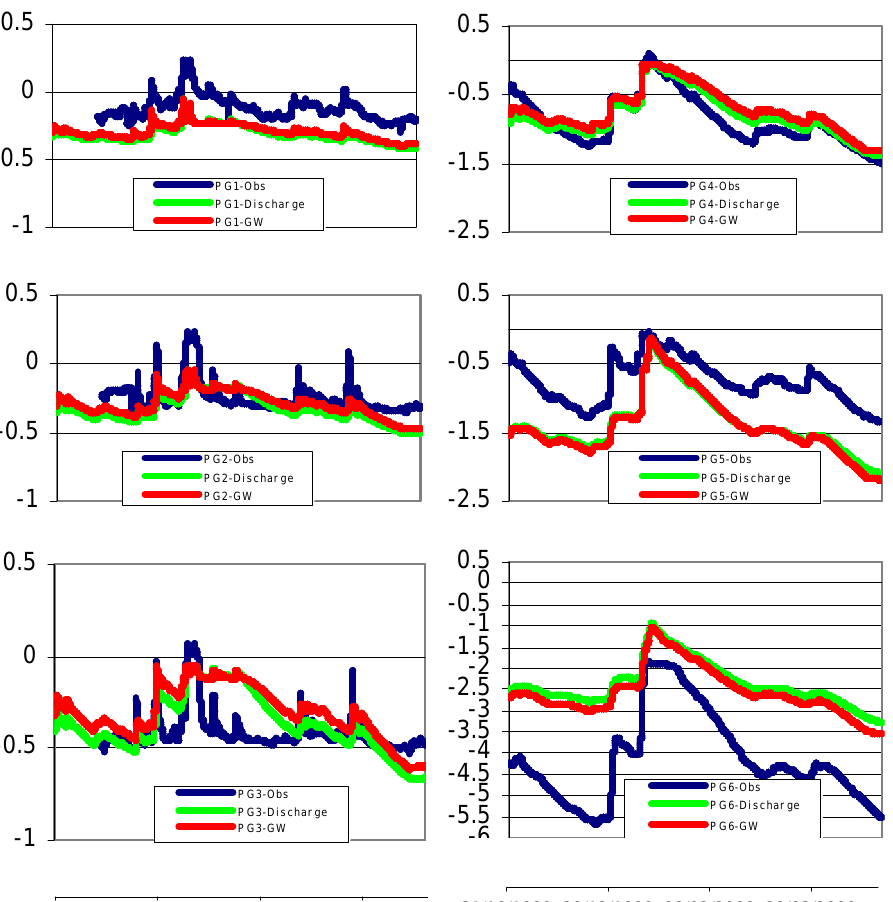
Fig. 5. Temporal variation of water table depth at the six wells in the water year 1999–2000, from 31 October to 31 March: observed values, simulated values fitted to discharge and fitted to water table depth considering no spatial variation of physical